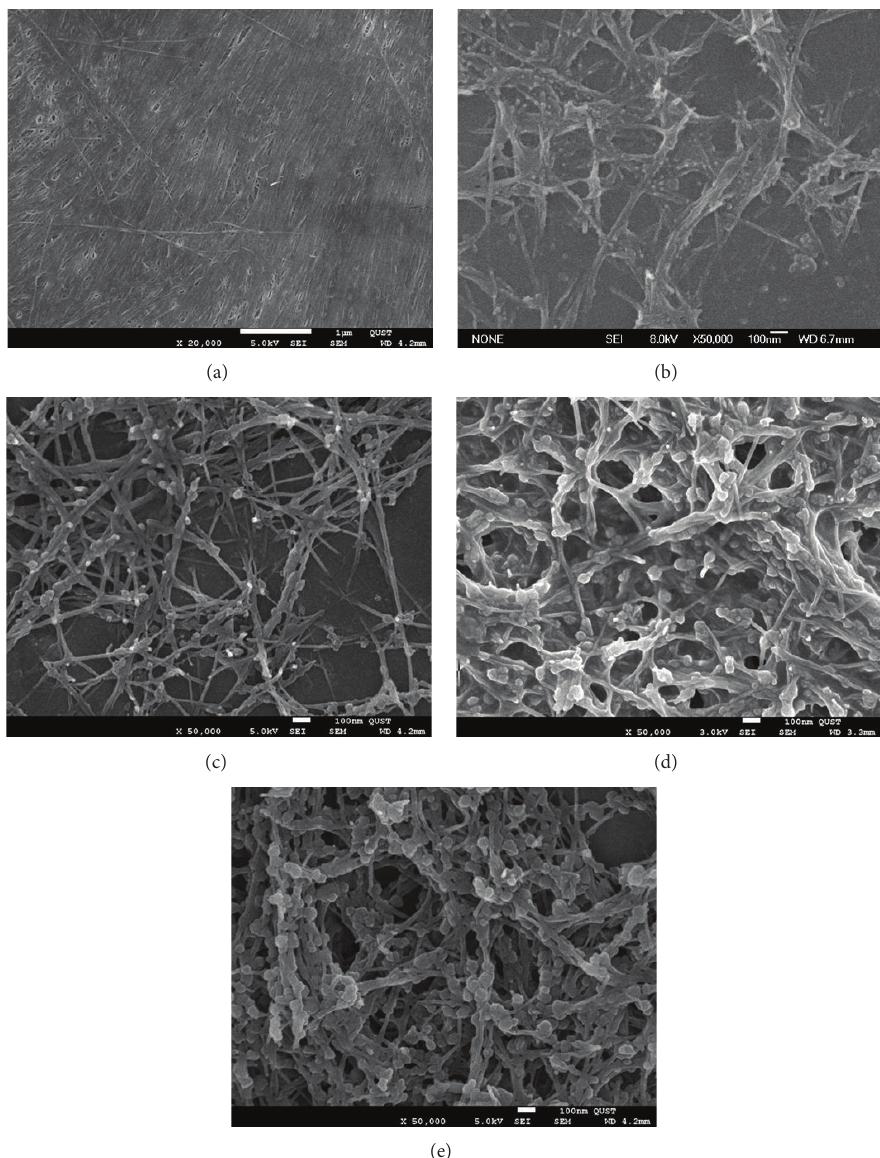
Figure 3: SEM images of T-CNs (a) and the PPy/T-CNs nanocomposites (b)–(e). The amount of Py in the nanocomposites was 0.5 (b), 1.0 (c), 2.0 (d), and 5.0 mmol (e),